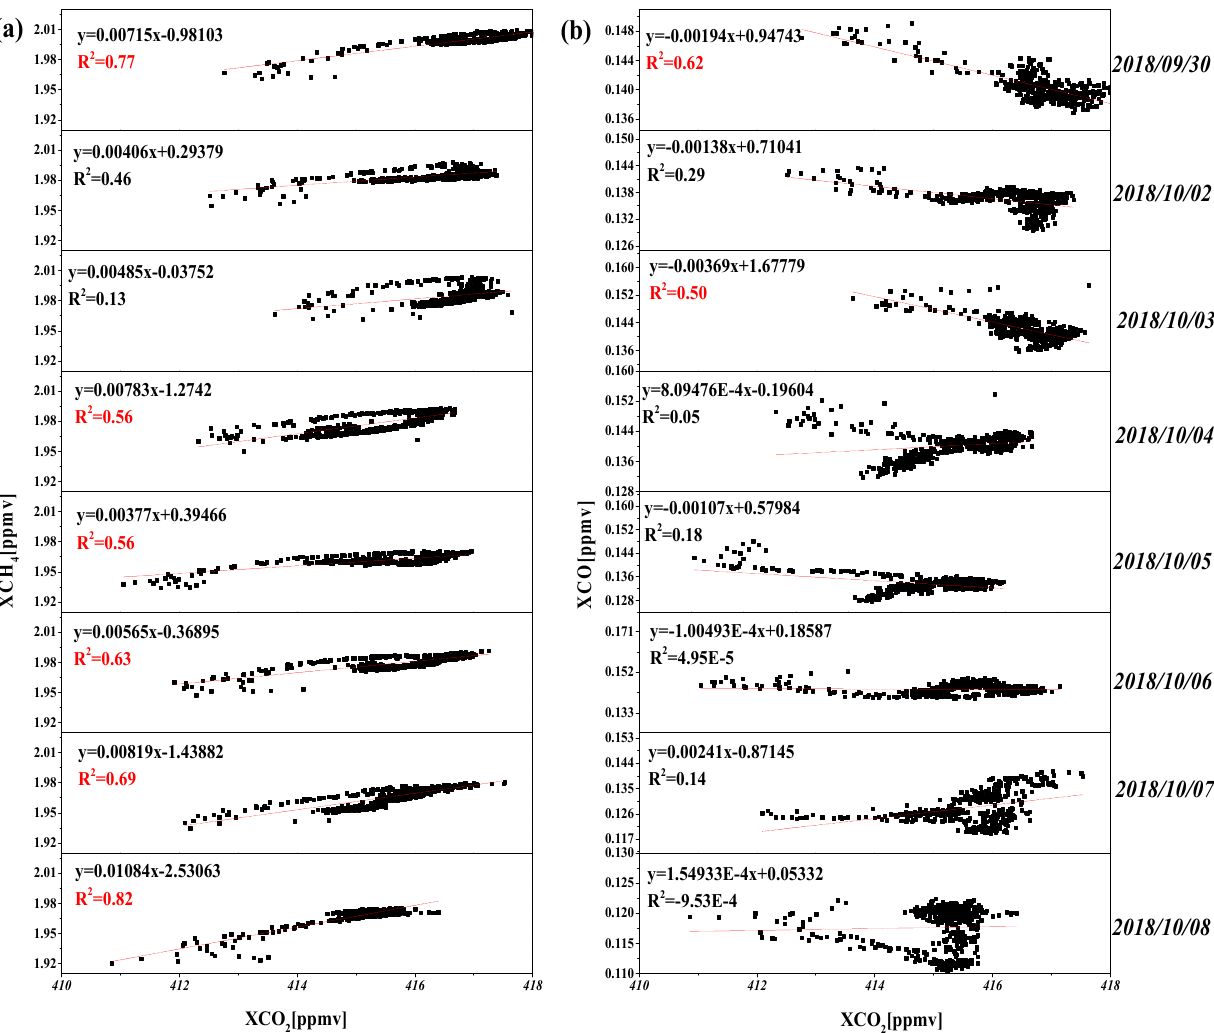
Figure 8. The correlation between XCH 4 and XCO 2 ( a ), the correlation between XCO and XCO 2 ( b ) from 30 September 2018 to 8 October 2018.